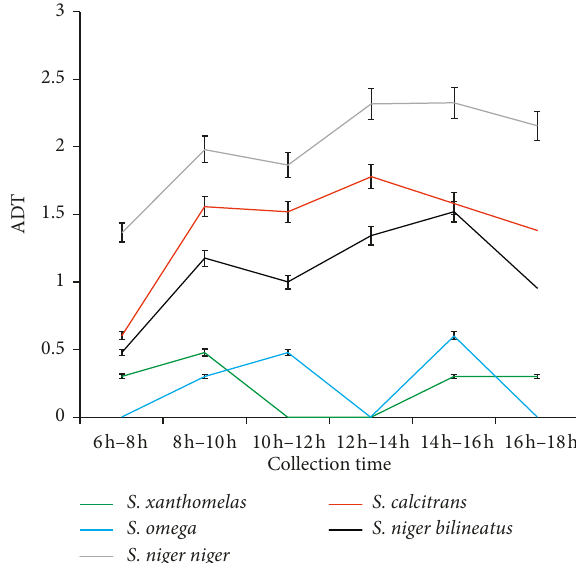
Figure 3: Daily activity rhythms of Stomoxys spp. in the rainy season (May 2017). ADT: trap apparent